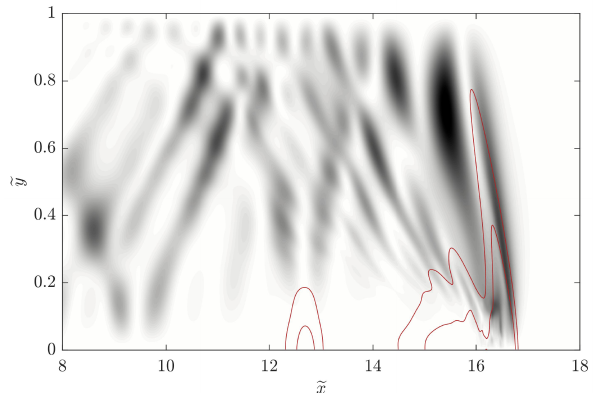
Figure 5. Vertically integrated v 2 at e t = 10 . 4 (t = 100s ) for case 10_1. Red contours are level curves of the vertically integrated